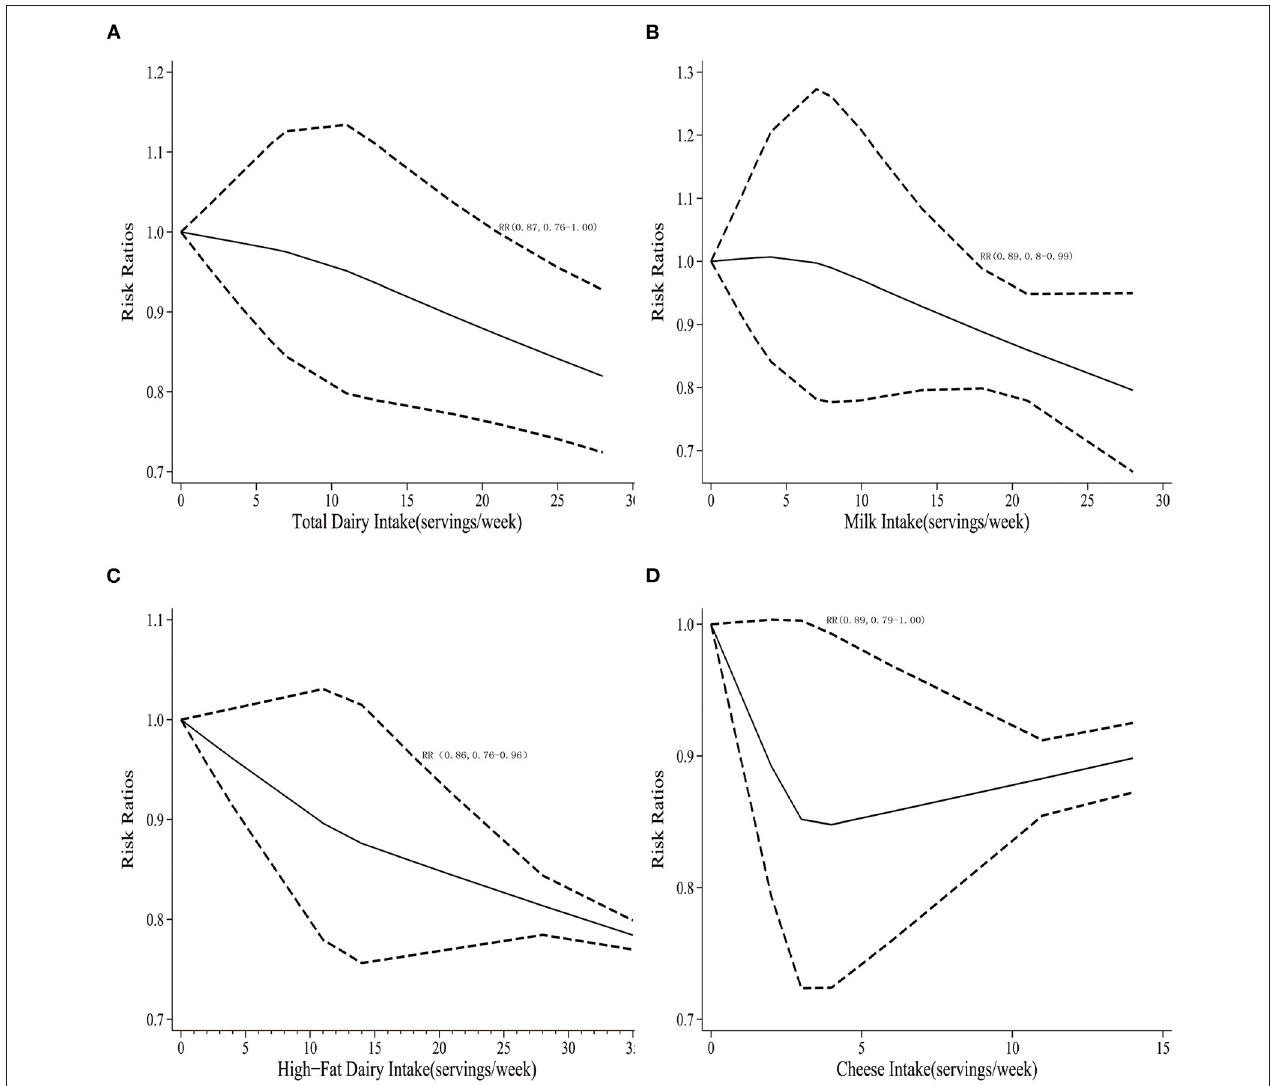
FIGURE 3 | (A) Dose-response for total dairy products and the risk of endometriosis. (B) Dose-response for total milk products and the risk of endometriosis. (C) Dose-response for high-fat dairy products and the risk of endometriosis. (D) Dose-response for cheese and the risk of endometriosis.